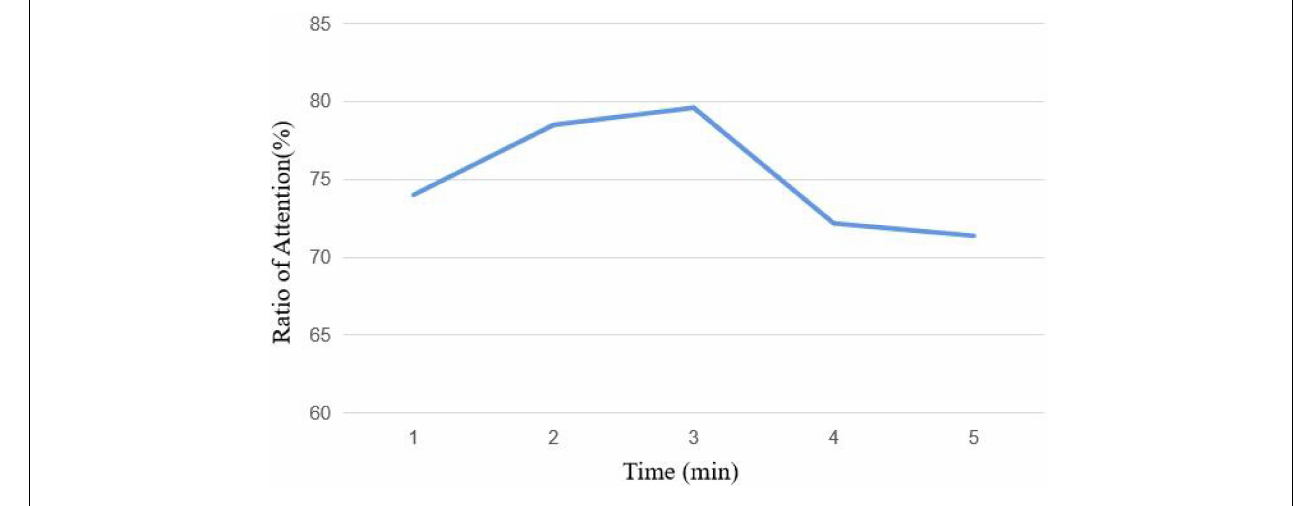
FIGURE 11 | Attention curve of course 1.